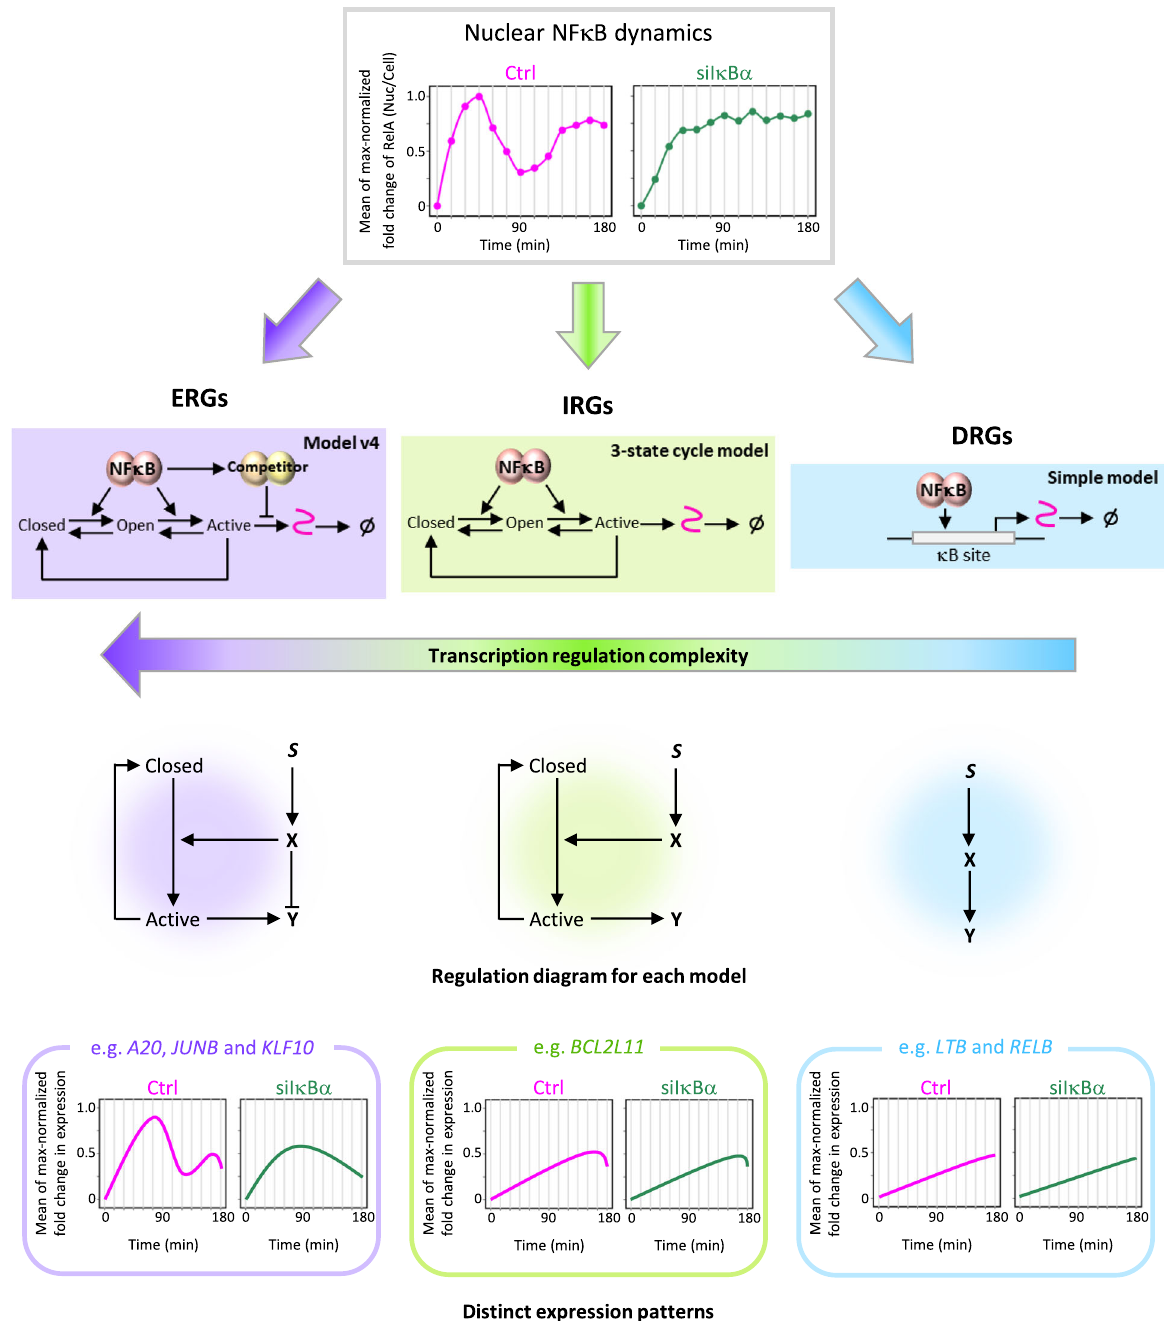
Fig. 5 Distinct regulatory mechanisms of NF κ B target genes depending on their response time. Diagram of the distinct transcription regulatory mechanisms that characterizes each TNF-induced NF κ B target gene cluster. Mean fold change in nuclear NF κ B abundance of two biological replicates in Ctrl and siI κ B α were interpolated to every second (same method used in mathematical modeling) and were max-normalized from 0 to 1 together, shown as line graphs in the top panel. The dots indicate the data from fi xed-cell immuno fl uorescence experiments. The bottom panel shows the schematic curves of the expression patterns of ERGs, IRGs, and DRGs in subcluster 2. Despite the persistent pattern of nuclear NF κ B abundance in siI κ B α , post-induction repression was observed for the ERGs, and model v4 was the most effective model to recapitulate post-induction repression and reduced expression. For the IRGs, the 3-state cycle model was the most effective model, and for the DRGs, the simple model was the most effective model. The complexity of the transcription regulatory mechanisms increases as the response time of transcription decreases. In fl ammation and cancer-related JUNB and KLF10 , respectively, showed a transient fold change in expression, indicating that post- induction repression mechanism safeguards gene expression from overproduction, protecting from in fl ammatory diseases and tumor